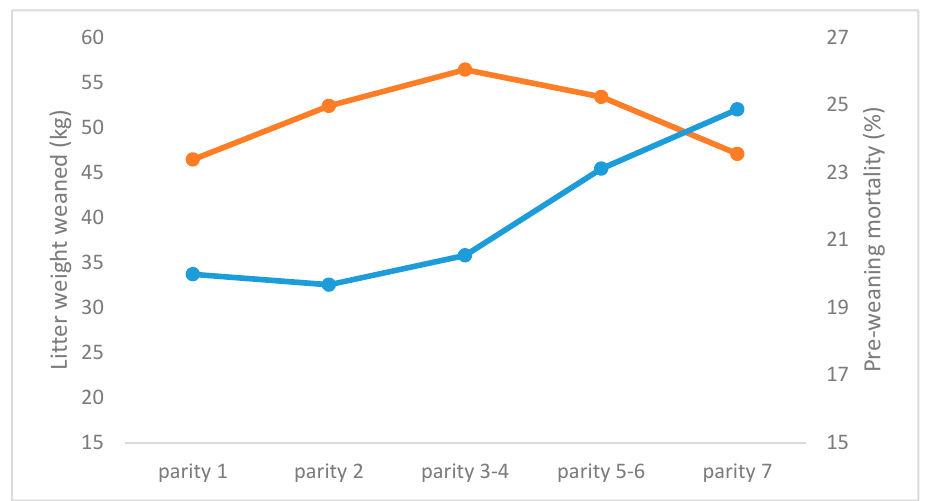
Figure 3. Litter weight at weaning (kg, orange line) and pre-weaning mortality (%, blue line) for sows with increasing parity (adapted from [48]).